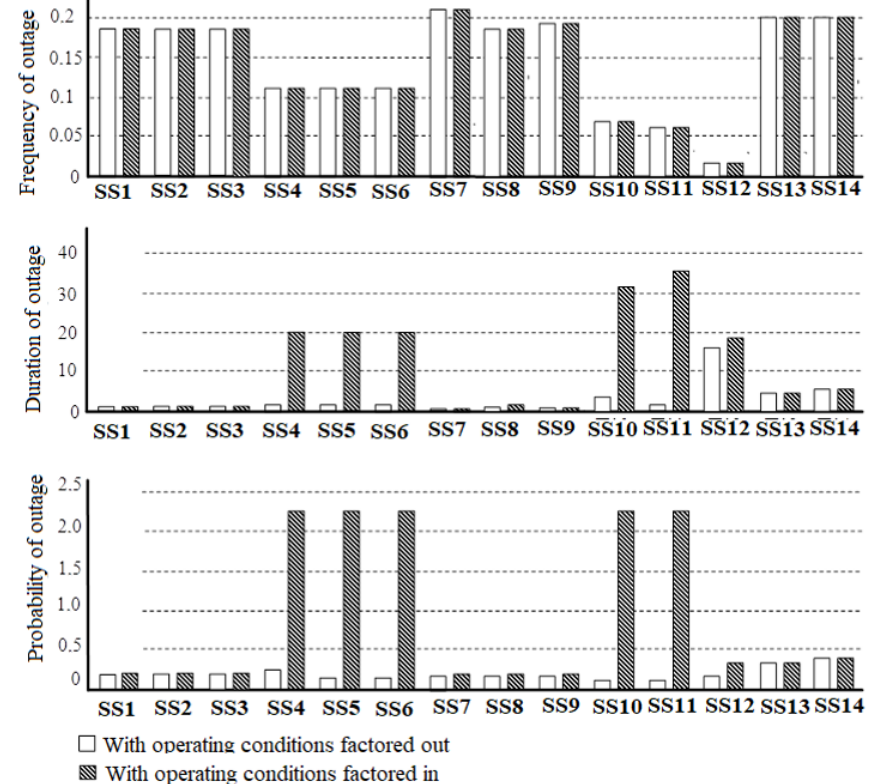
Figure 10. Reliability metrics for Structure 4 of the distribution network. Formulas (1)–(3) were used to perform calculations of system reliability metrics.